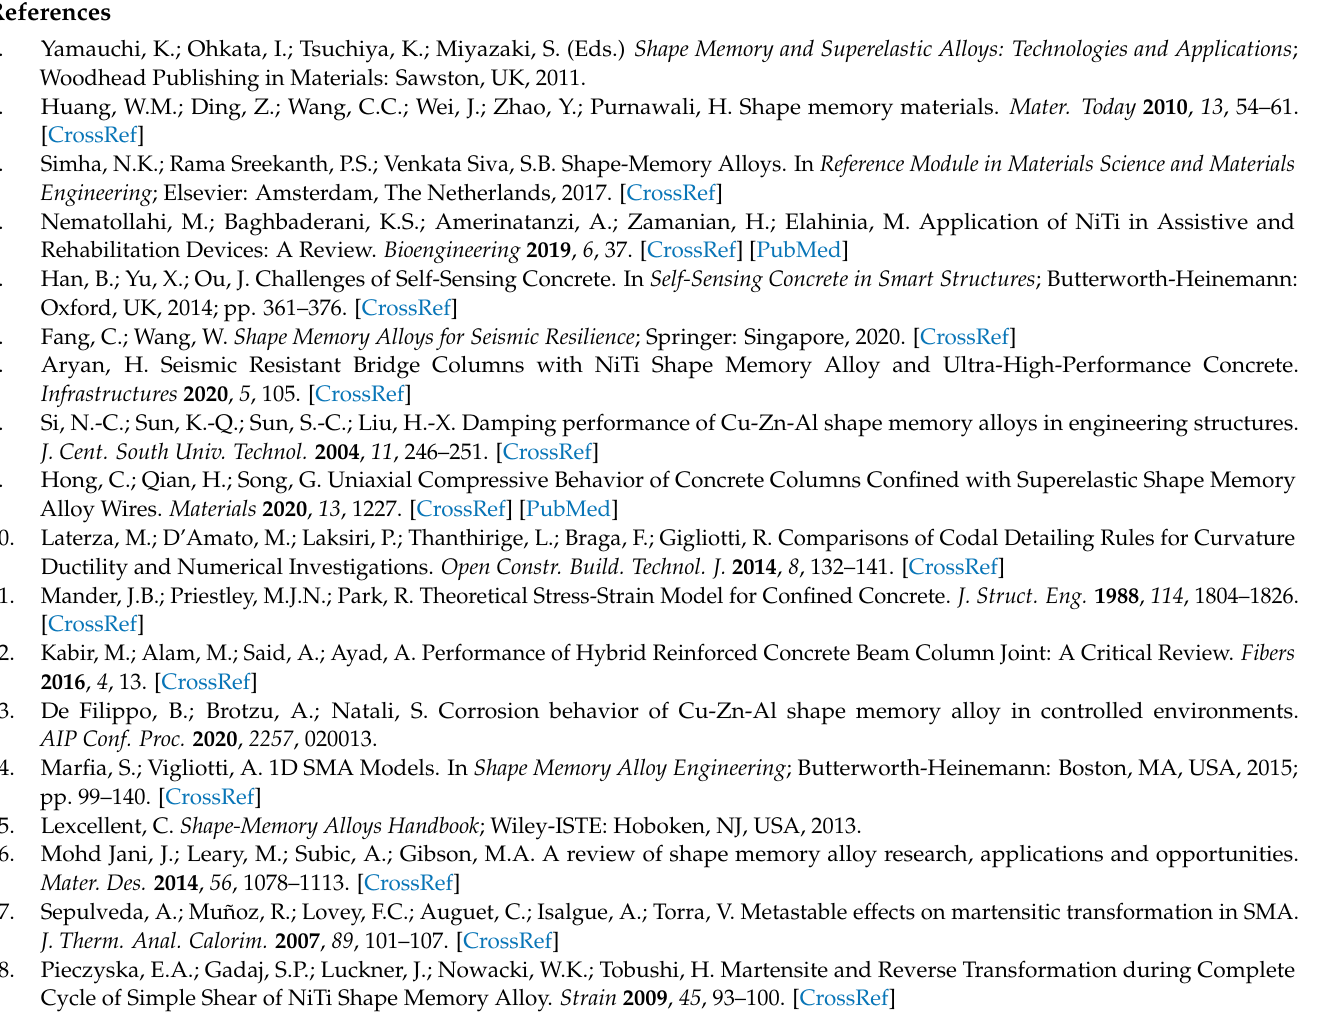
(v) Although the shape memory alloy was strengthened, the super elasticity effect was not lost. The strain recovery by super-elastic effect approximately amounts to 6%. (vi) The applied ausforming thermomechanical treatment facilitates the achievement of enhanced strength and at the same time the reversible austenitic–martensitic transformation capability. This transformation is important for many mechanical and construction engineering demands where the super-elastic effect is or could be used, such as the earthquake energy